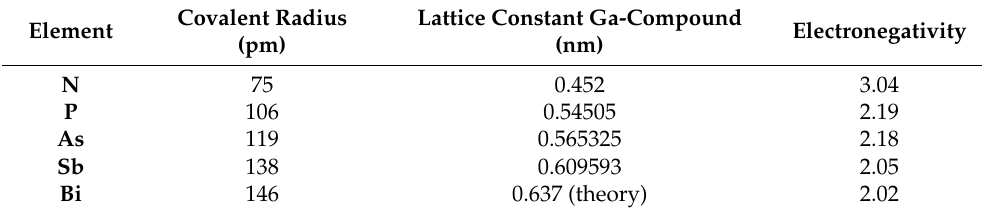
Table 1. Characteristic properties of group-V elements [1]. Adapted with permission from